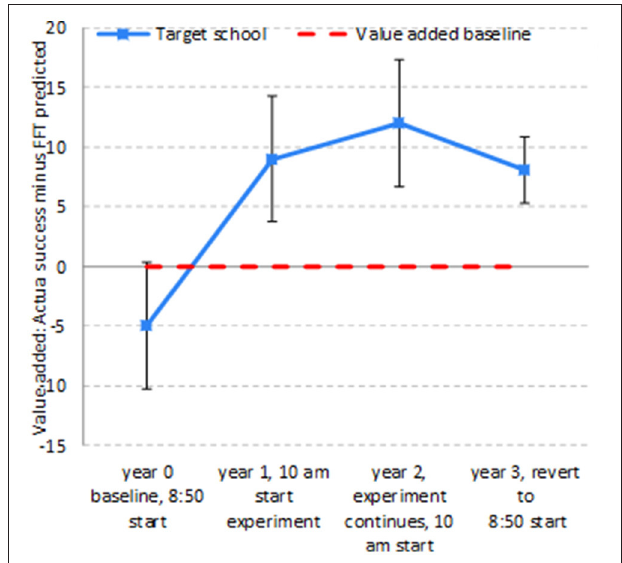
FIGURE 2 | Academic success: value added by target